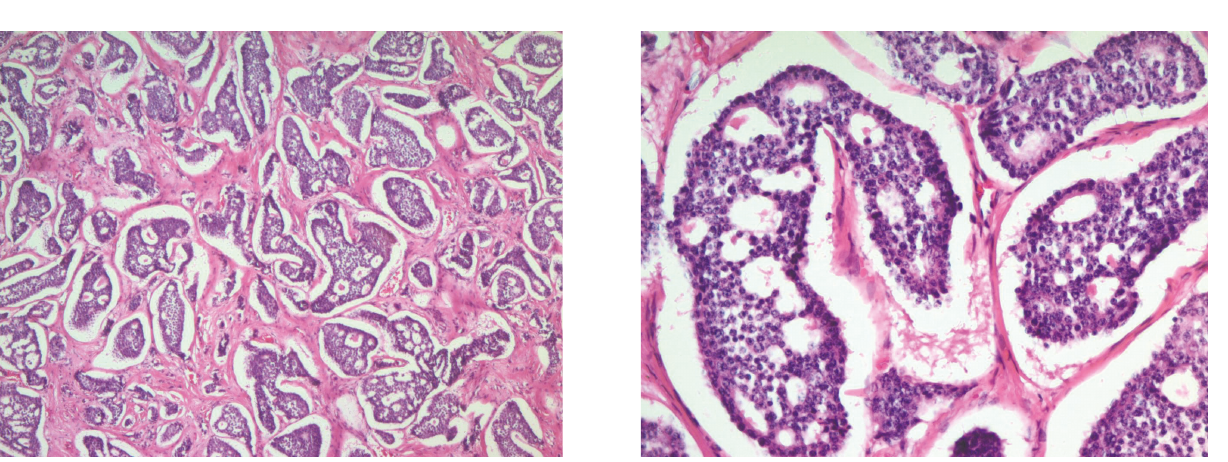
Figure 2: Cohesive cuboidal cells with minimal amount of cyto- plasm, round uniform nuclei with regular contour, finely granular chromatin, no nucleoli, and no mitotic activity (H&E; 200x).